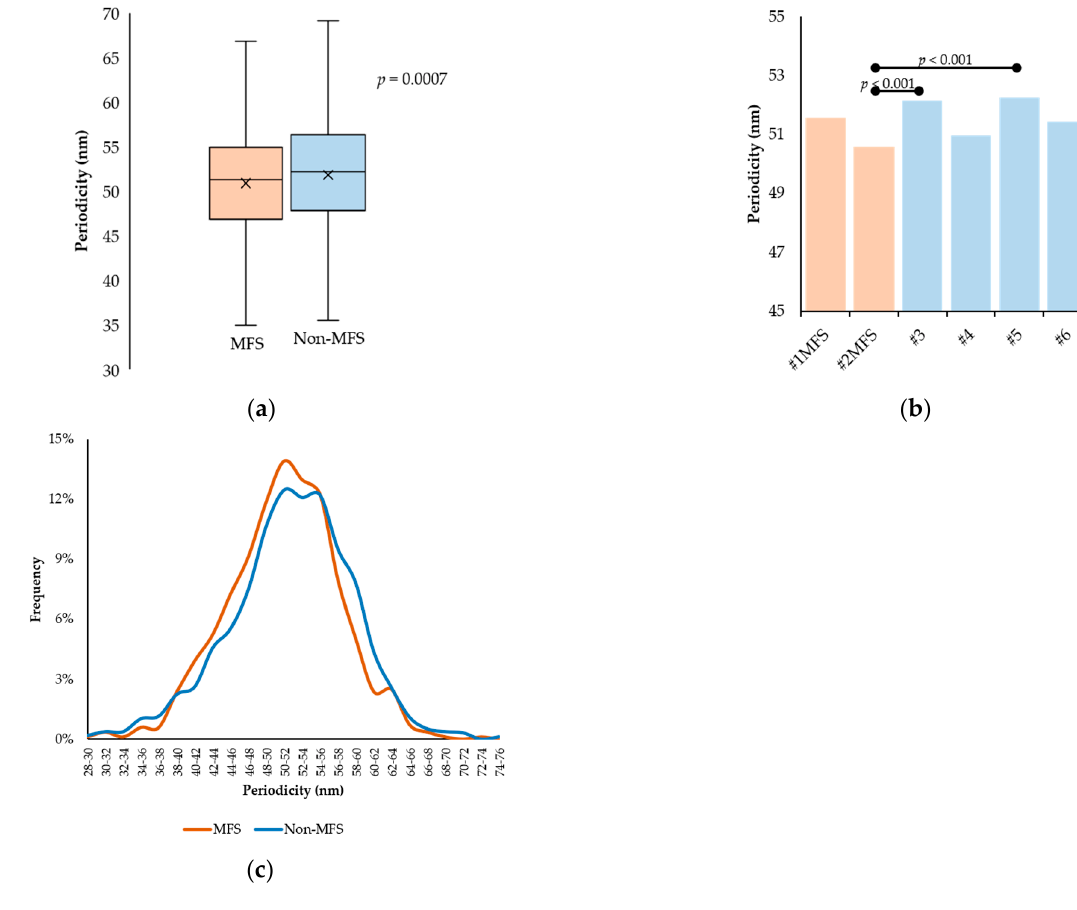
Figure 4. Comparison of interbead periodicity in MFS and non-MFS fibrillin microfibrils. ( a ) Statistical comparison of pooled periodicity values in the two populations. ( b ) Comparison of mean periodicities between individual samples. The horizontal lines indicate pairs of samples displaying statistical di ff erences. ( c ) Distribution of periodicity in the two studied groups.